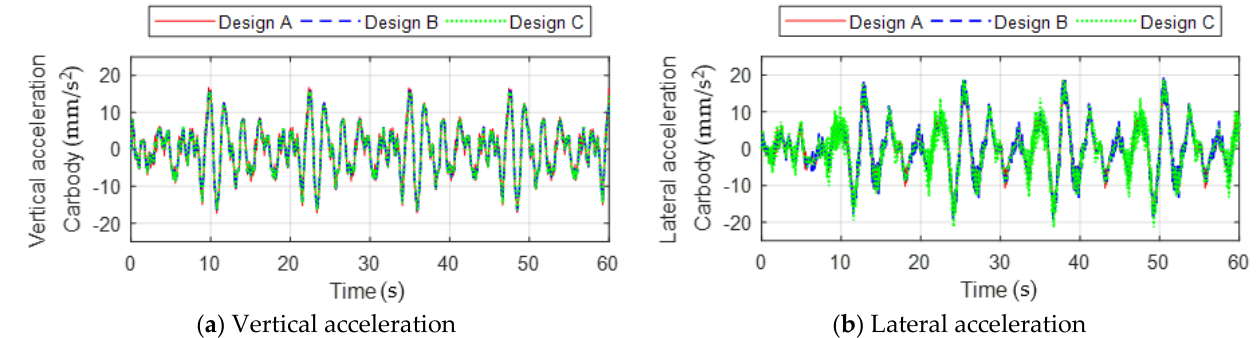
Figure 24. Vertical and lateral accelerations of a carbody at a speed of 900 km/h.